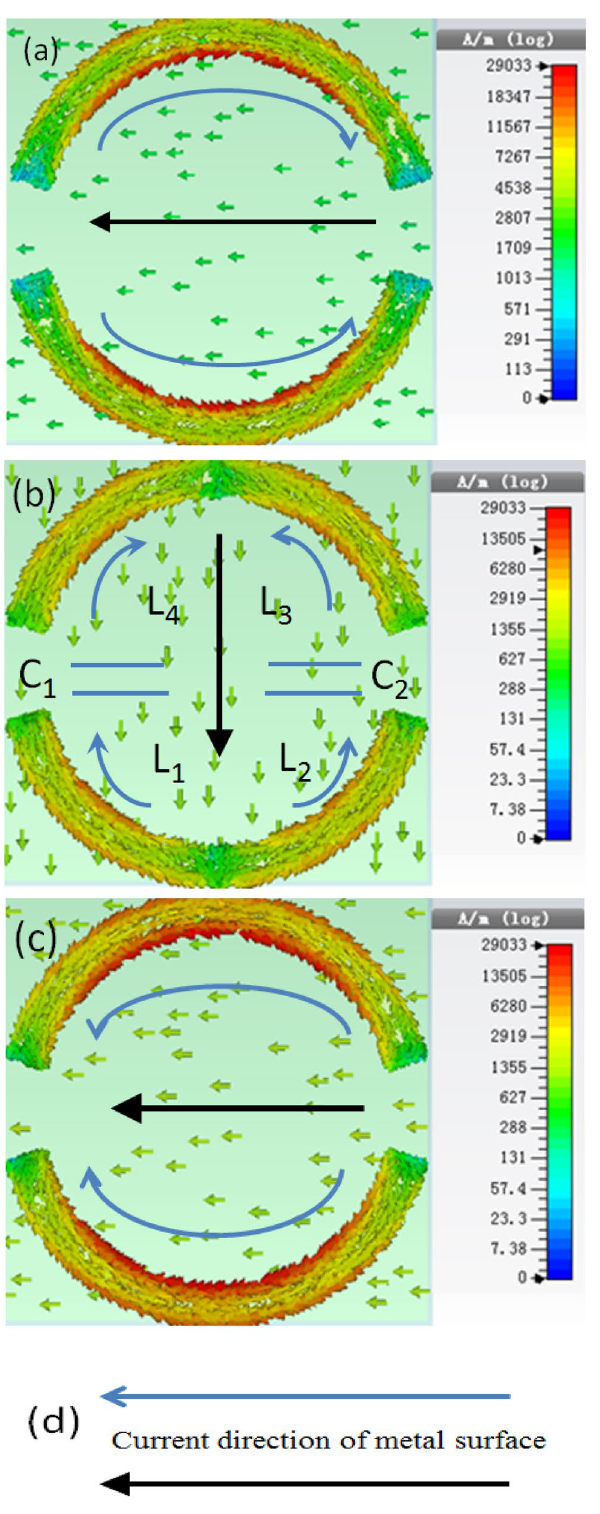
Fig. 5 Current distributions at the top and bottom metal plates at resonance frequencies: a 0.578 THz; b 1.1288 THz; c 1.6868 THz; d Illustration showing current directions